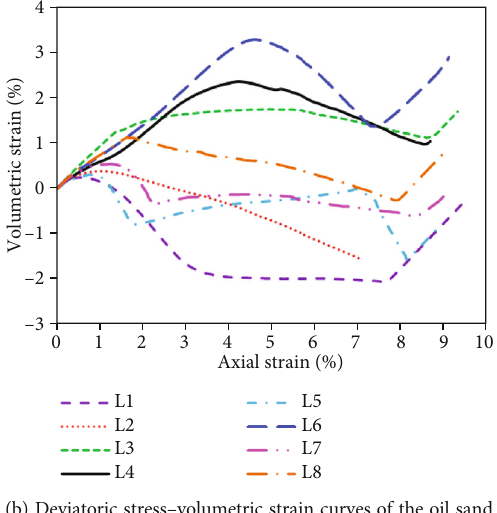
Figure 7: Characteristics of oil sand deformation under di ff erent temperatures and con fi ning